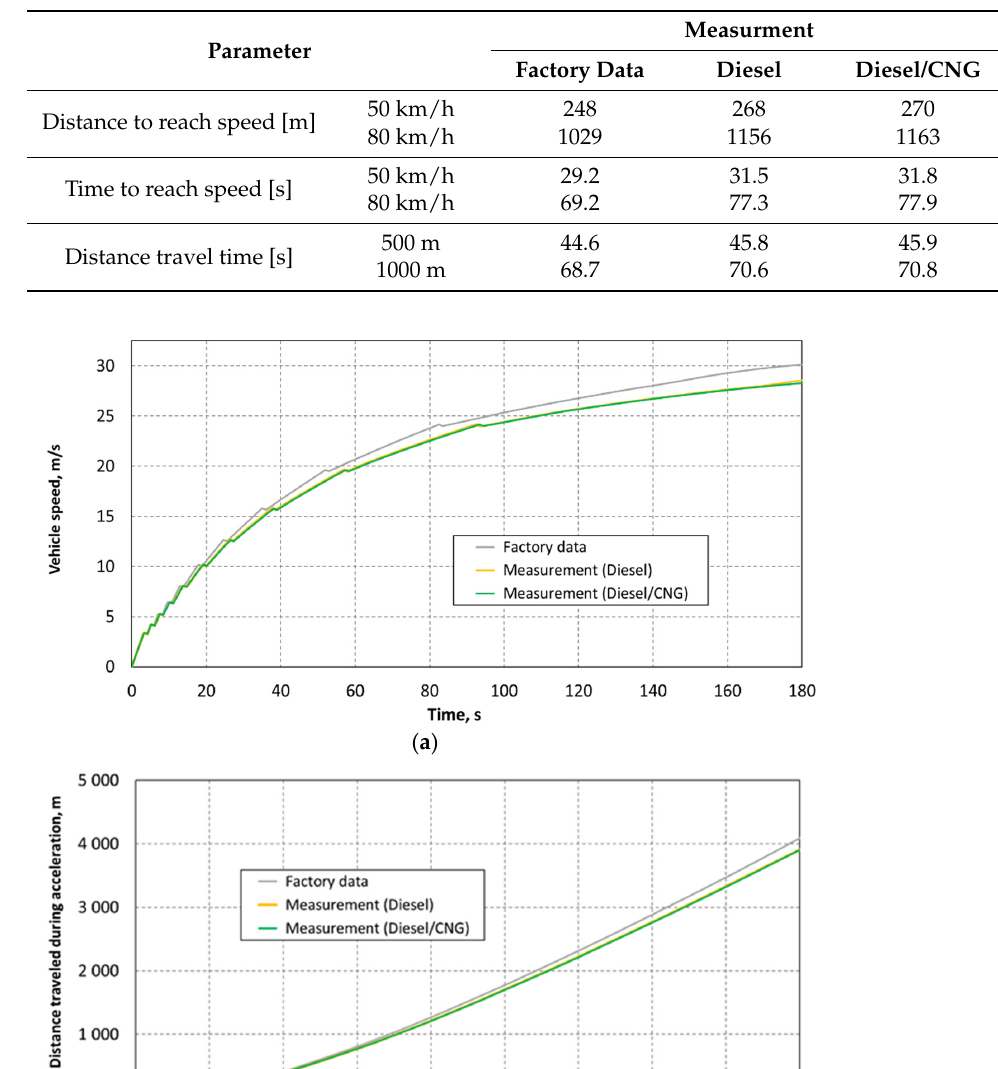
Table 5. Parameters of the acceleration process.